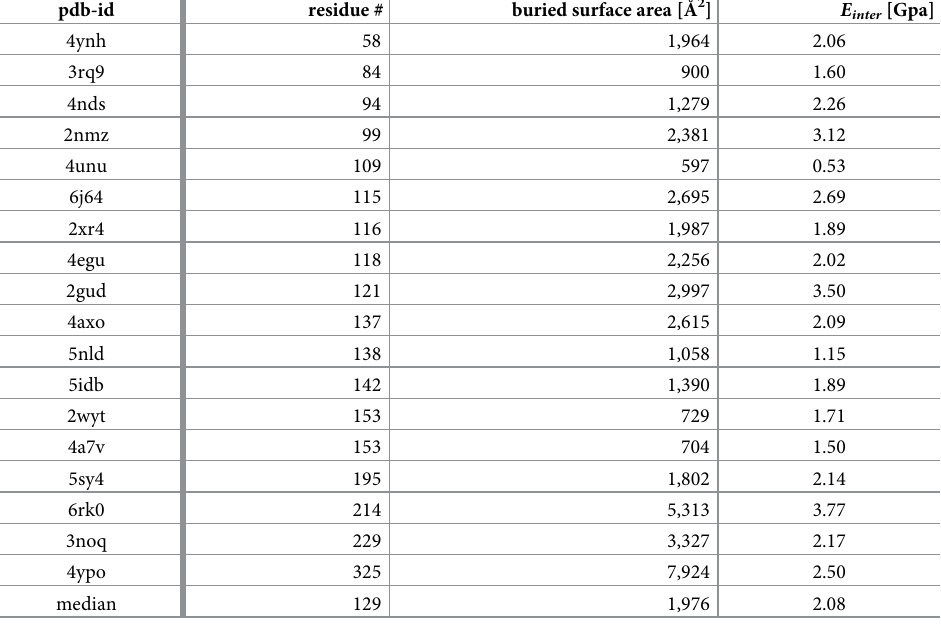
Table 3. The buried surface areas and the Young’s moduli ( E high resolution structures from the PDB that are in the form of homodimers in the asymmetric